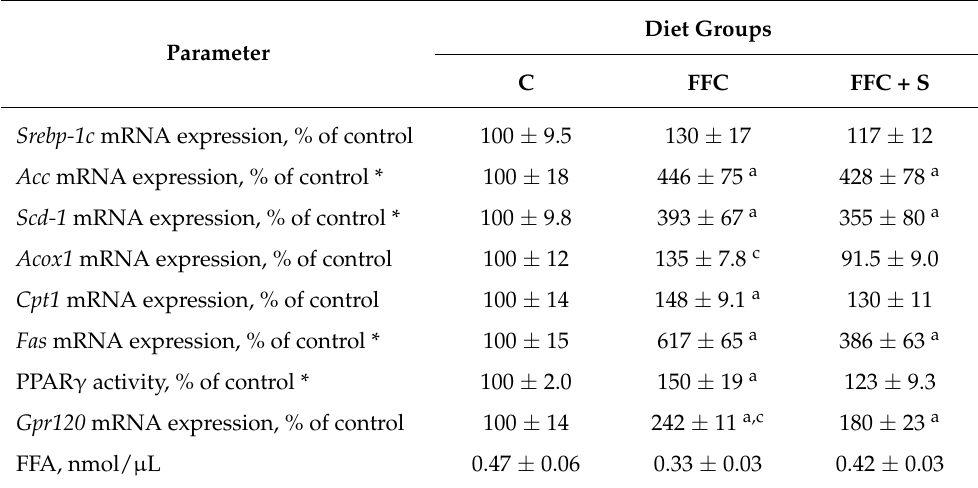
Table 2. Effect of fortifying the fat-, fructose-, and cholesterol-rich diet with 4E% soybean oil on hepatic markers of lipid metabolism and inflammation in